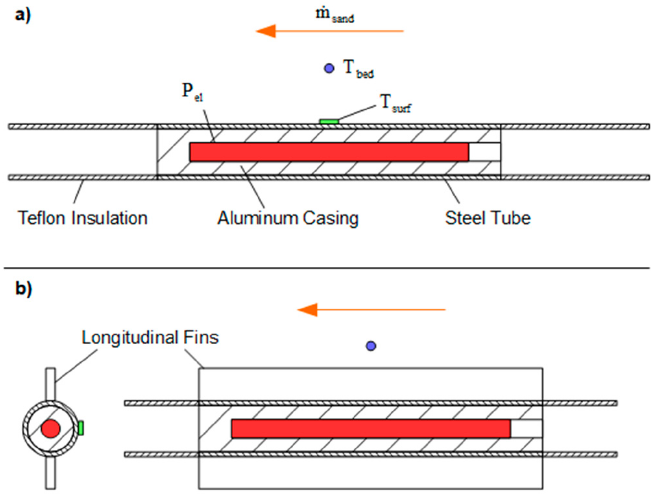
Figure 5. LINI test tube configuration: ( a ) Plain tube; ( b ) Longitudinally finned tube.